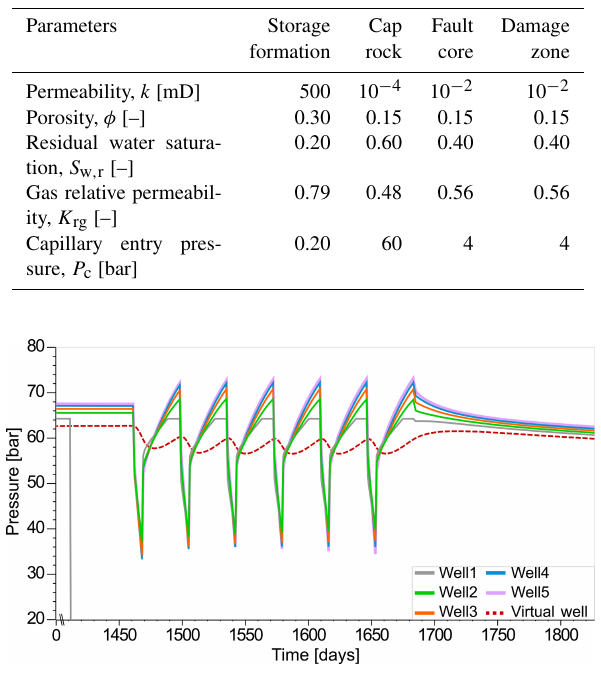
Table 1. Model parameters used for 3-D gas storage simulation.